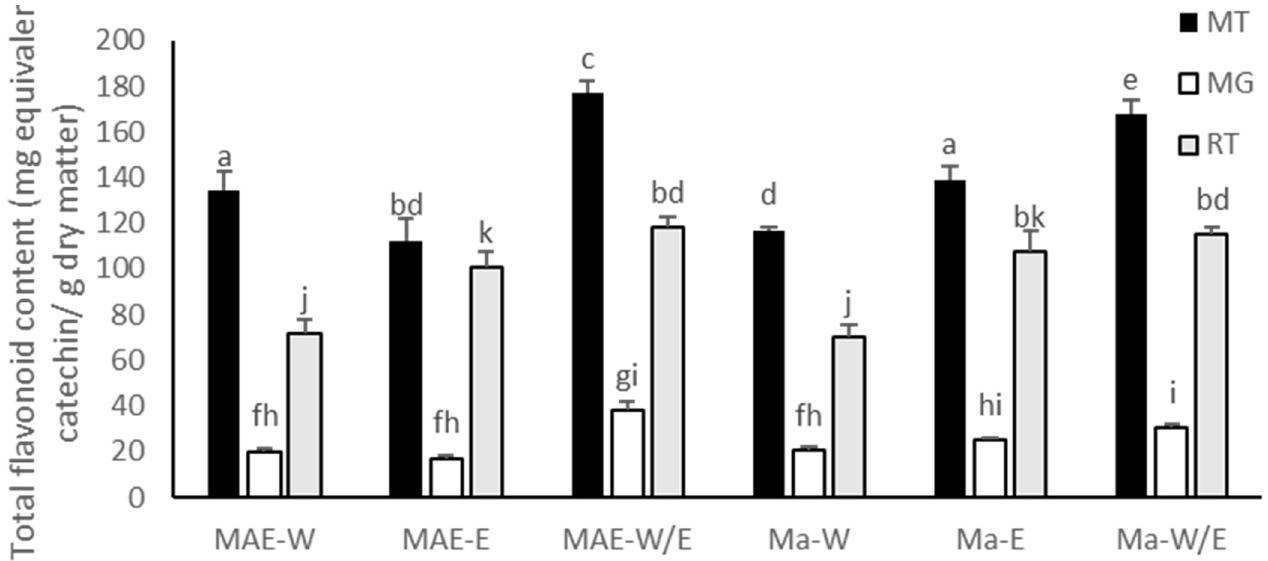
Figure 2. Total flavonoid content of extracts in mg equivalent catechin/g dry matter: mangosteen peel (MT); mango peel (MG); rambutan peel (RT); microwave-assisted extraction (MAE); maceration (Ma); water (W); ethanol 95% (E); water–ethanol (40:60%) (W/E). The data are presented in terms of Mean ± S.D. Different letters (a–k) indicate a significant difference ( p < 0.05) between each bar.